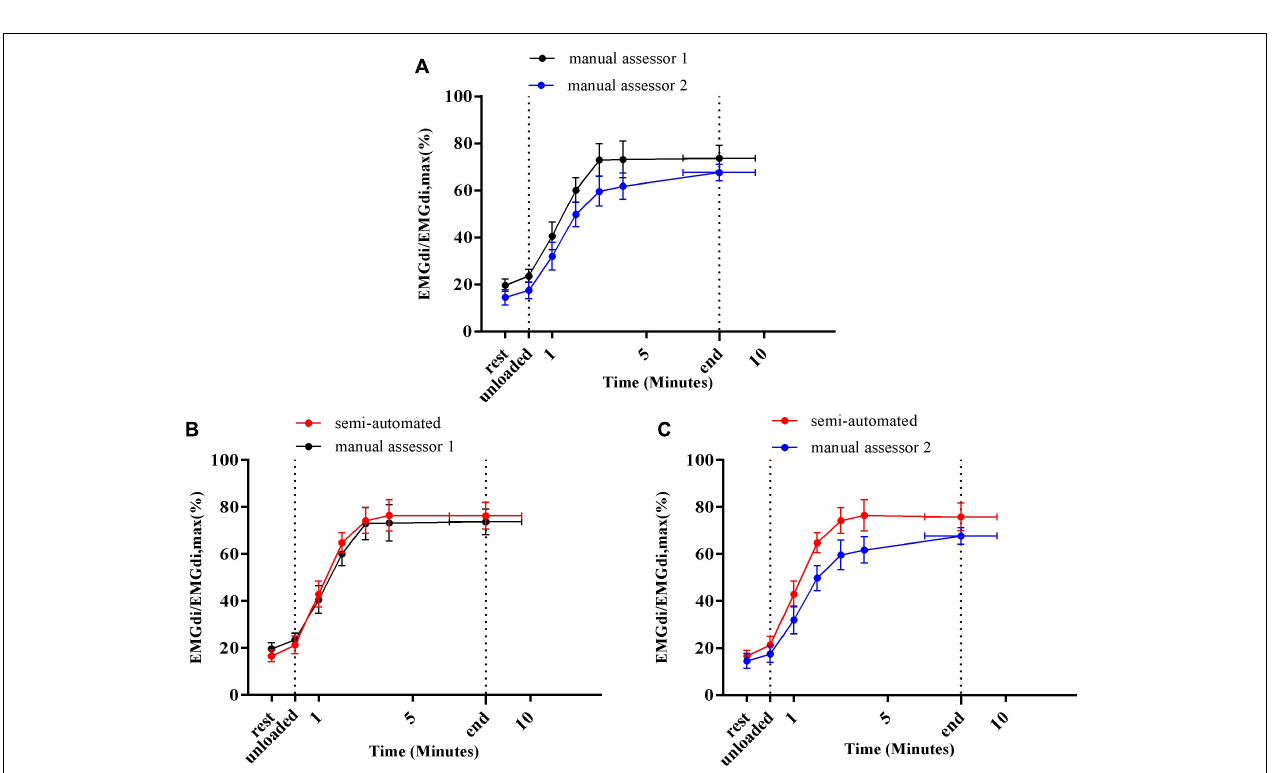
FIGURE 6 | Average diaphragm activation (EMGdi/EMGdiMax%) of seven patients during CWR cycling test at pre-measurement calculated from the manual method by two assessors (A) ; the semi-automated method and the manual method by assessor 1 (B) ; the semi-automated method and the manual method by assessor 2 (C)